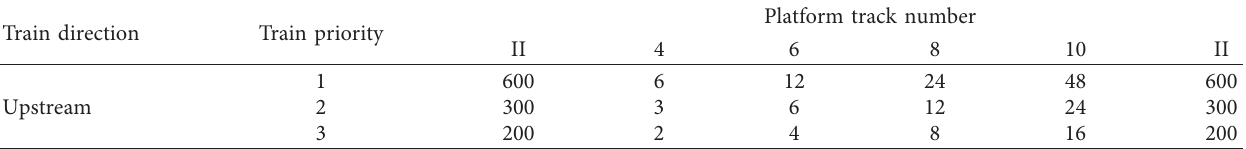
Table 5: Platform track assignment costs for upstream trains with different